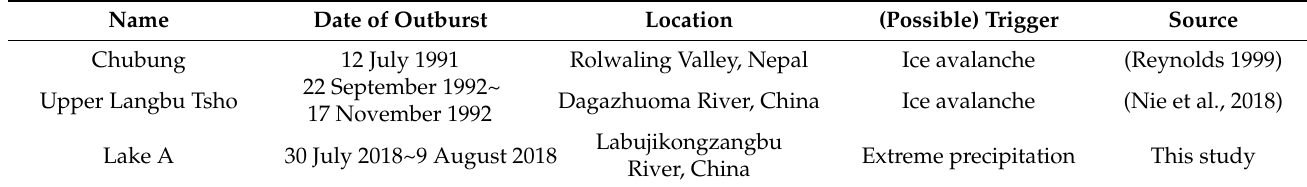
Figure 8. GLOF events, hydropower projects, and population tendency (left 2000 and right 2018) in the basin. Table 6. Historical GLOF events of the basin.